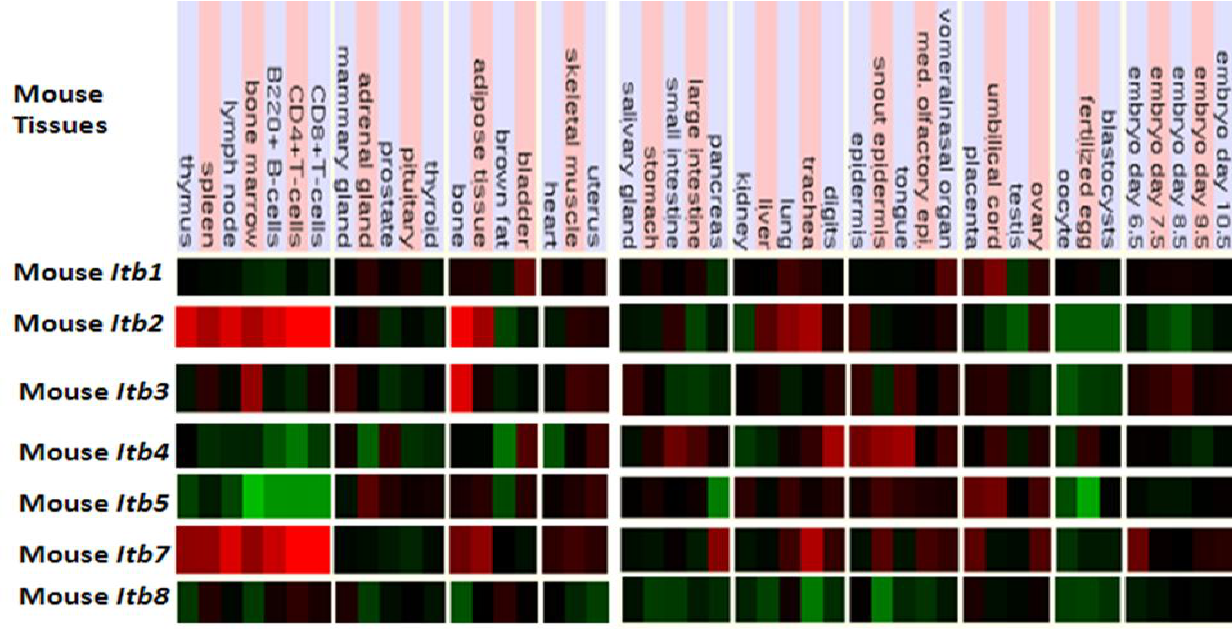
Figure 5. Comparative tissue expression for mouse beta integrin genes ( ITB ). Expression ‘heat maps’ (GNF Expression Atlas 2 data) (http://biogps.gnf.org) [91] were examined for comparative gene expression levels among human and mouse tissues for ITB genes showing high (red); intermediate (black); and low (green) expression levels; derived from mouse genome browsers (http://genome.ucsc.edu)